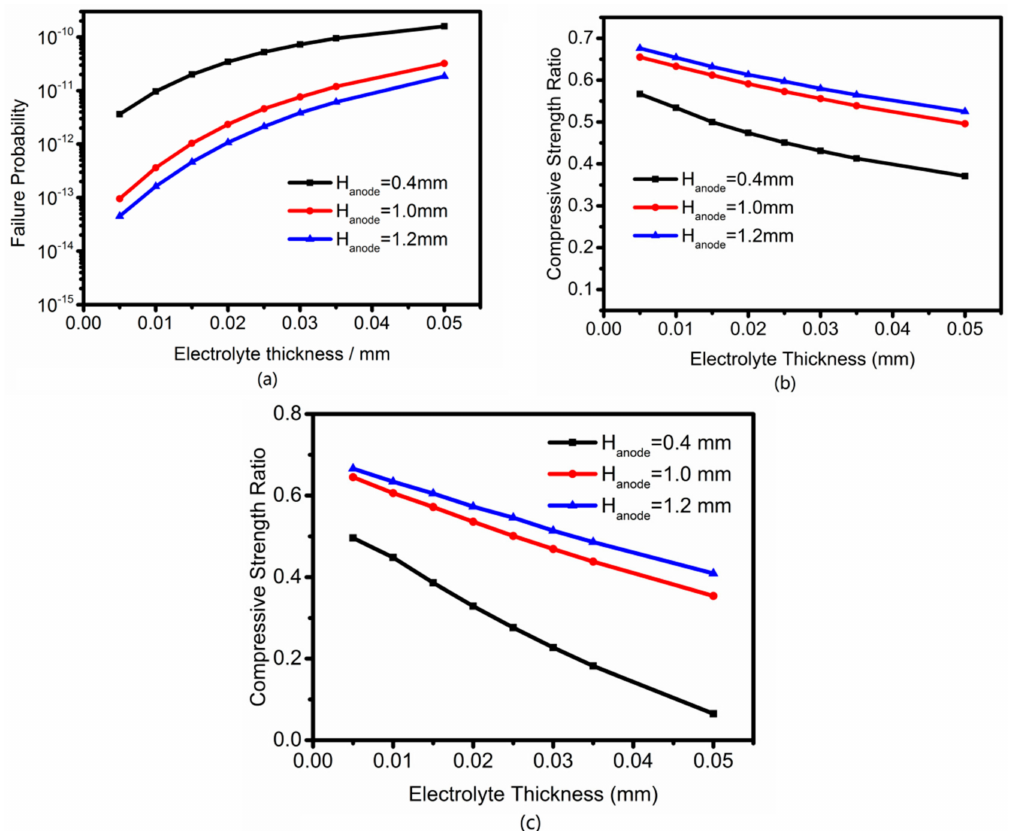
Figure 7. Effects of the electrolyte layer thickness on ( a ) the anode failure probability; ( b ) the compressive stress strength ratio of the electrolyte; ( c ) the compressive stress strength ratio of the cathode. Results corresponding to the three anode layer thicknesses of H anode = 0.4, 1.0, and 1.2 mm are shown in black, red and blue,